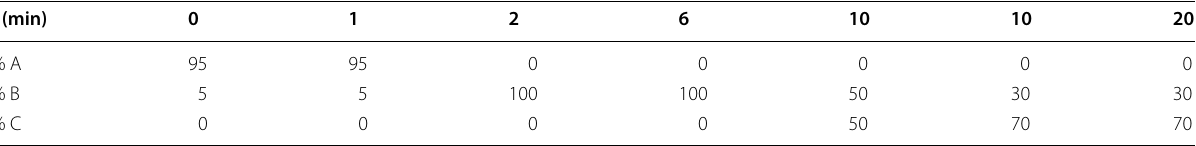
Eluent A is MQ water, eluent B is acetonitrile and eluent C is isopropanol